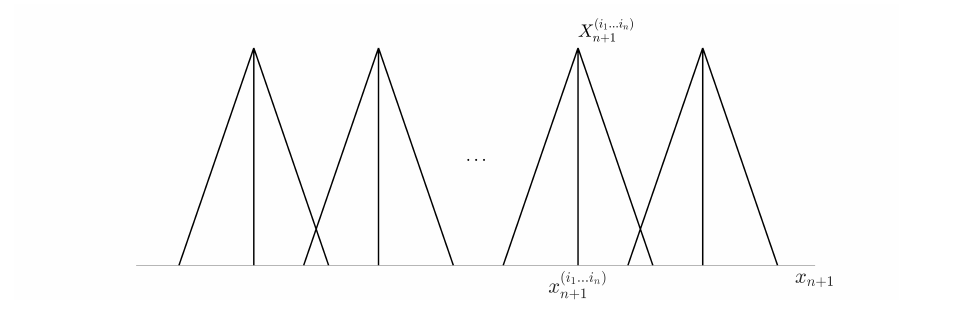
Figure 2. Output membership function x n + 1